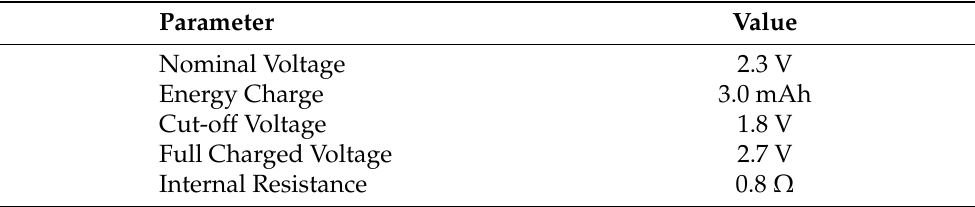
Table 2. Characteristic parameters for the underwater sensor node battery.